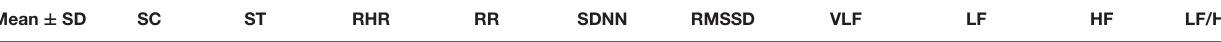
TABLE 2 | Electrophysiological parameters across the three different conditions (baseline, stress exposure, and relaxation). Mean ± SD SC ST RHR RR SDNN RMSSD VLF